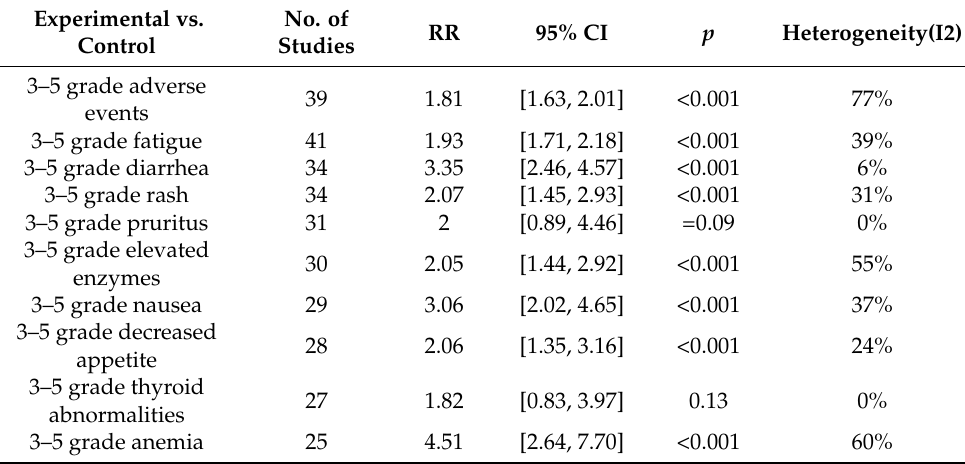
Table 5. Subgroup analysis of 3–5 grade adverse events. Experimental